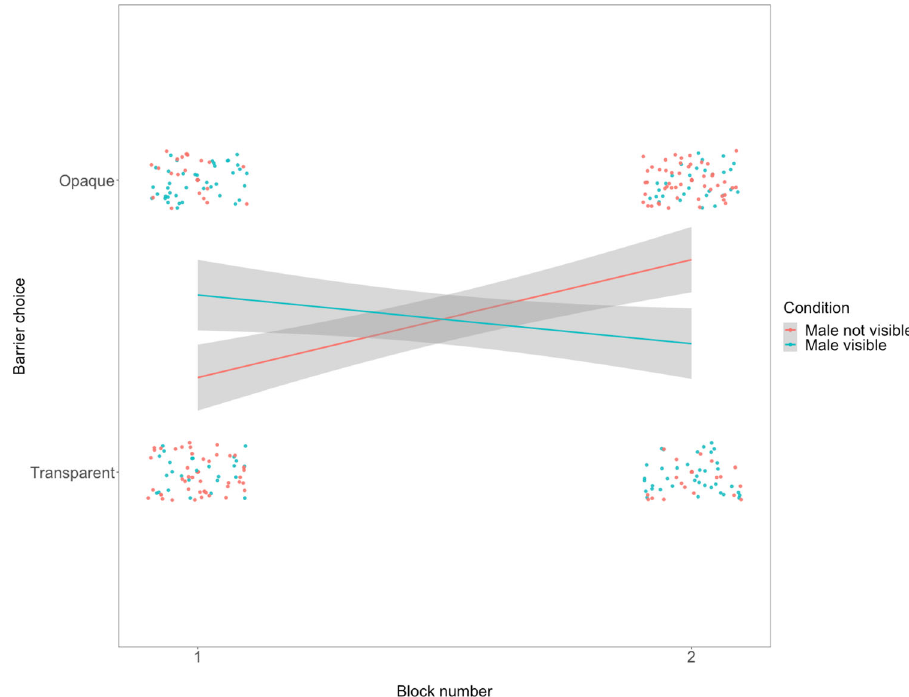
Fig. 3 Opaque barrier choices by females in Study 2. Scatter plot of females ’ choices to feed behind the opaque barrier as a function of round with plotted lines from a linear model separated by condition ( N = 11 pairs of fi sh). Gray shaded area shows con fi dence